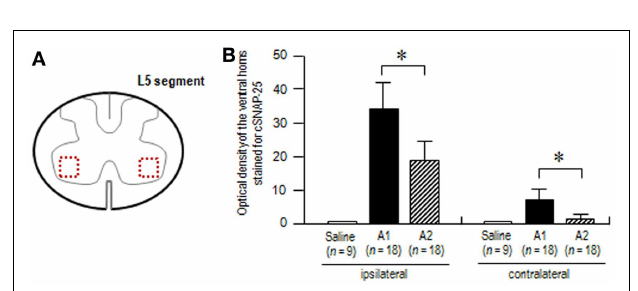
FIGURE 6 | Densitometric analysis on the spinal ventral horns stained for cSNAP-25 .The optical densities of cSNAP-25-immunoreactive products were measured in the spinal cord at the L5 segmental level 4days after unilateral injection of saline, BoNT/A1 (10U) or BoNT/A2 (10U) into the left gastrocnemius muscle. (A) The scheme shows the transverse spinal cord section at the L5 segment, in which measured areas in the bilateral ventral horn are indicated by dashed open boxes colored in red. (B) Optical densities of the ventral horns stained for cSNAP-25 in rats treated with saline ( n = 3), BoNT/A1 (A1) ( n = 6), or BoNT/A2 (A2) ( n = 6). For each animal, measurements were made in the ventral horns of three spinal cord sections ipsilateral and contralateral to the toxin-injected sites.Values are means ± SD * P < 0.05, A1 versus A2; Mann–Whitney U